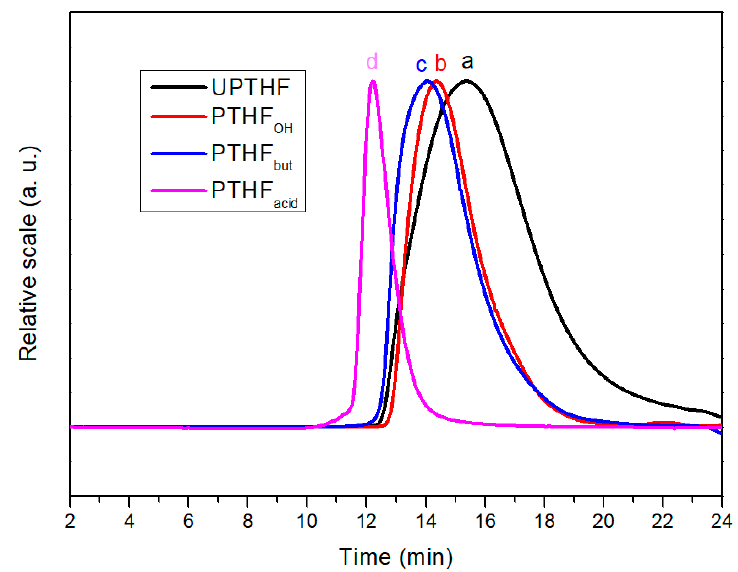
Figure 4. Size exclusion chromatography (SEC) elution curves of UPTHF ( a , sample 2 in Table 1), PTHF OH ( b ), PTHF but ( c ) and PTHF acid ( d ). Terahydrofuran (THF) was used as the eluent.